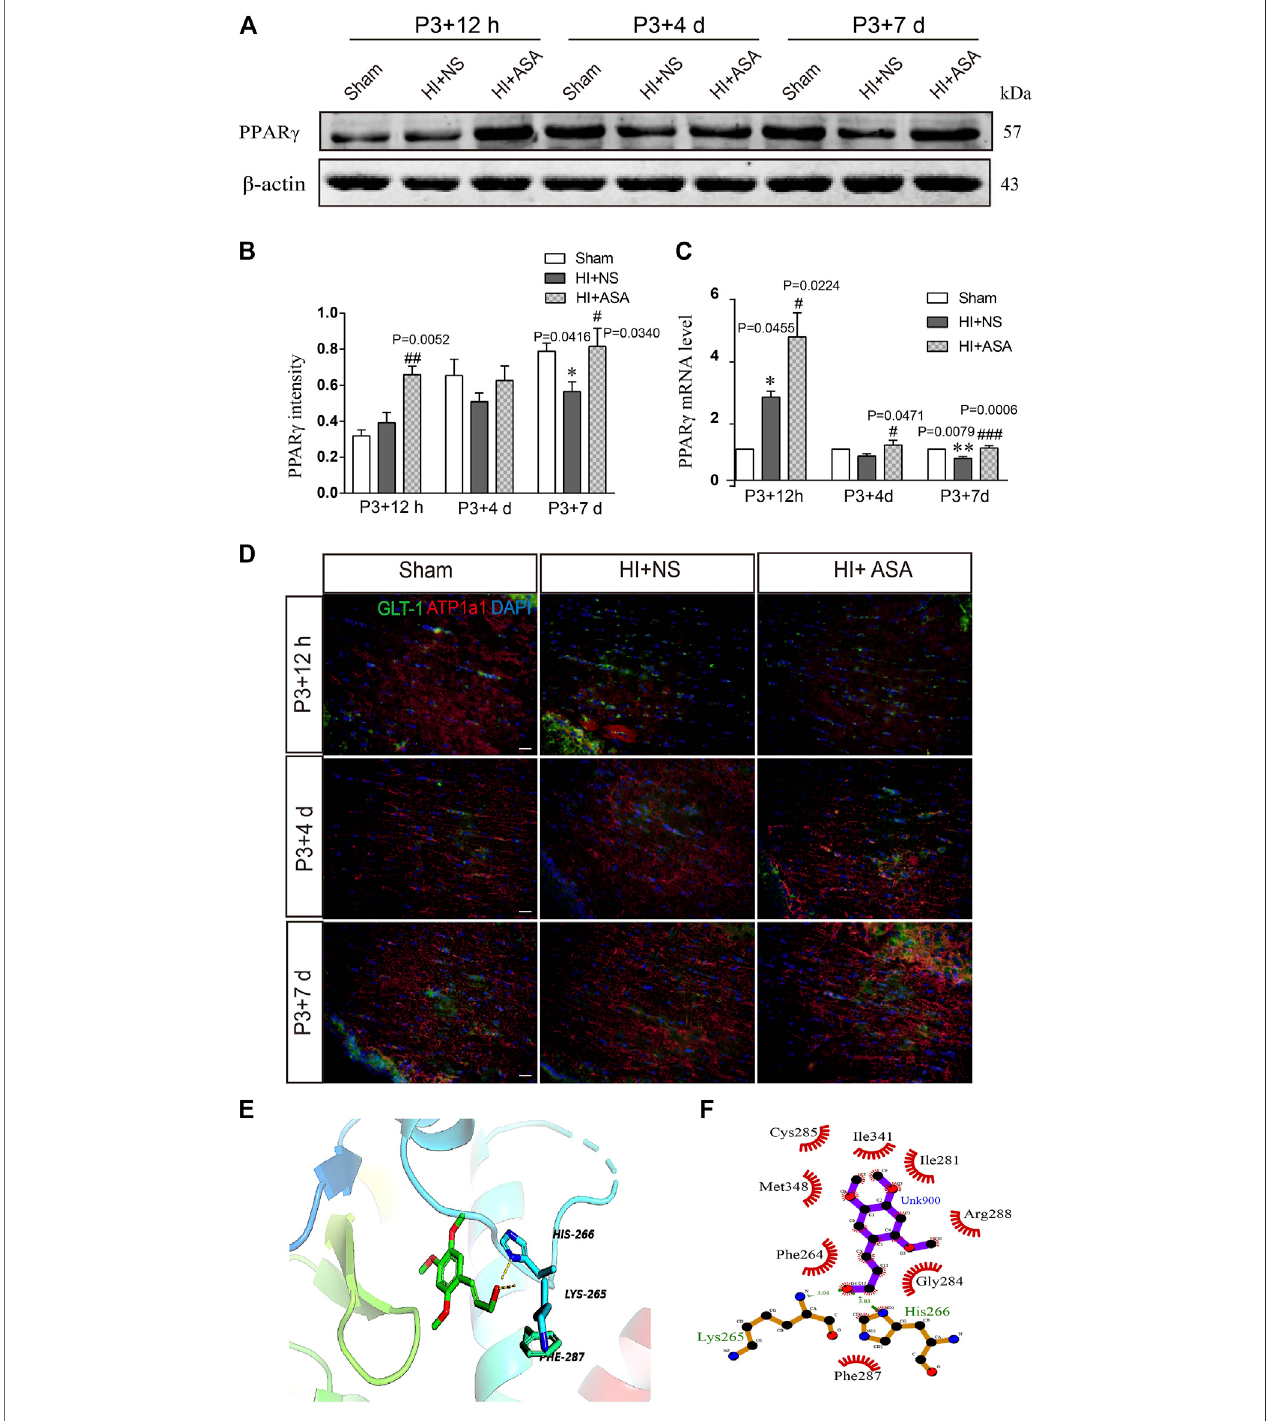
FIGURE5 | α -Asaronol increases the expression of PPAR γ inPWMI models. (A) Expression ofPPAR γ was detected at P3 +12 h, P3+ 4 d,and P3+ 7 d after HI. (B) PPAR γ wasquanti fi edandnormalizedagainst β -actin. (C) ThemRNAlevelofPPAR γ wasquanti fi edbyqPCR. (D,E) Representativeimmuno fl uorescenceimagesfor GLT-1and ATP1A1 double staining inthe corpuscallosum.Scale bar,20 µm. (F,G) Molecular docking simulationof α -asaronoland PPAR γ .All dataare representedas the mean ± SEM. * p < 0.05, ** p < 0.01 vs. sham group, # p < 0.05, ### p < 0.001 vs. HI + NS group. N = 4 for each group.